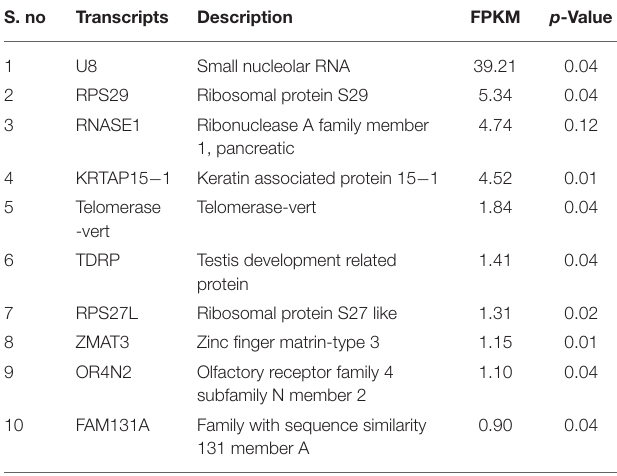
TABLE 4 | Top 10 abundantly expressed transcripts unique to good quality semen.